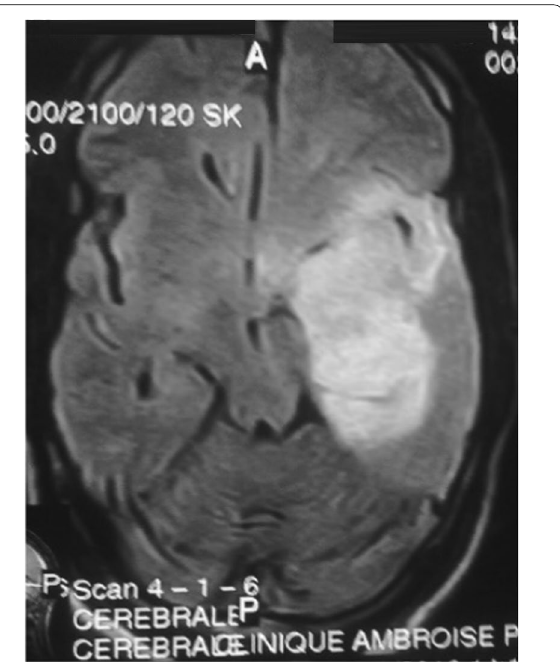
Fig. 3 MRI, Extensive lesion in T2 hypersignal, left temporo-parietal cortico-subcortical